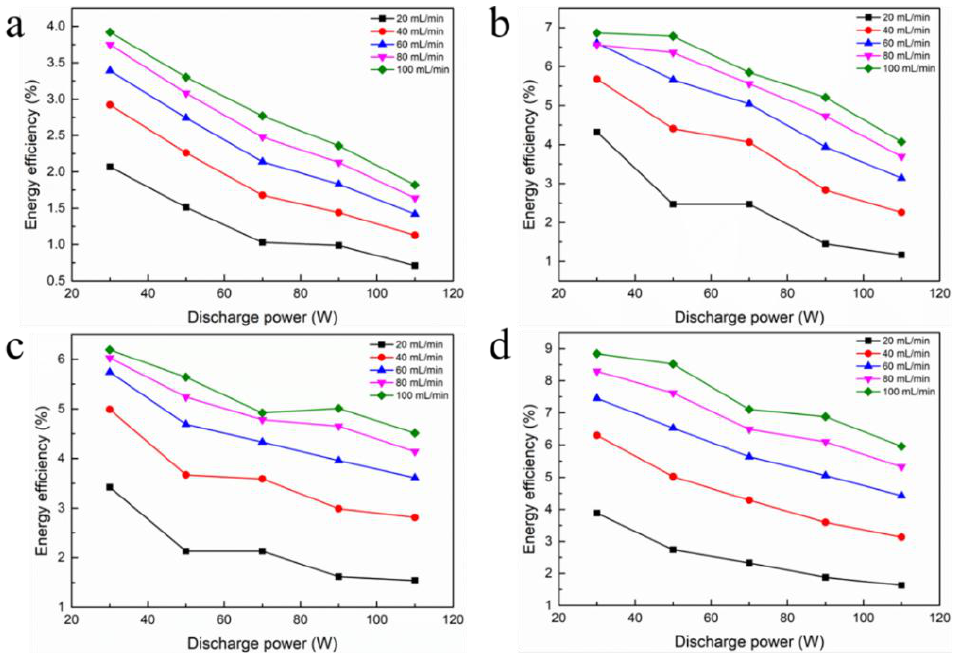
Figure 8. Effect of discharge power and gas flow velocity on energy efficiency: ( a ) Without packing; Figure 8. E ff ect of discharge power and gas flow velocity on energy e ffi ciency: ( a ) Without packing; ( b ) Foam Fe; ( c ) Foam Al; ( d ) Foam Ti. ( b ) Foam Fe; ( c ) Foam Al; ( d ) Foam